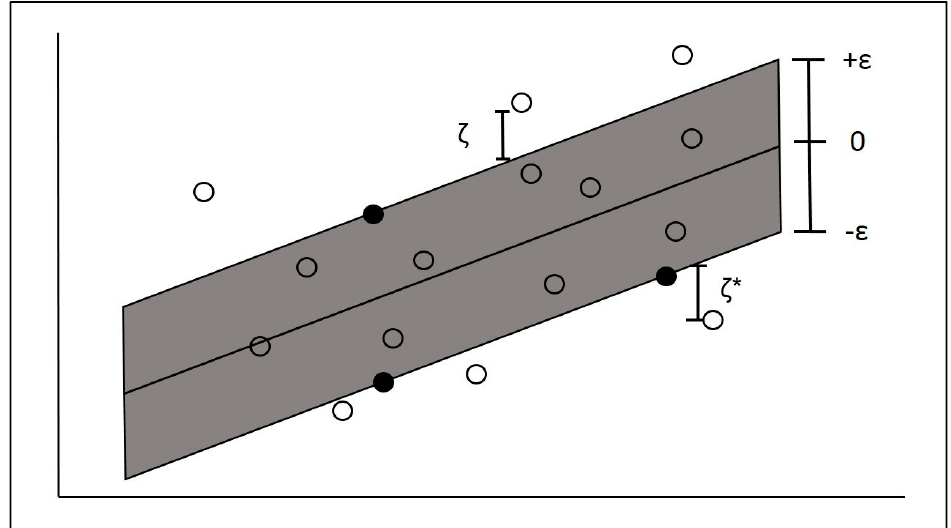
Figure 1. The Support Vectors (black filled circles) define the boundaries of the error tolerance band. Forecasted values greater than |𝜀| get a penalty equal to ζ according to their deviation from the tolerance band.